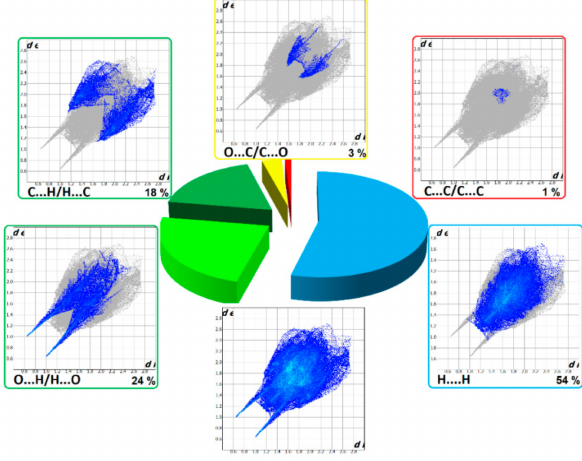
Figure 8. Full two-dimensional (2D) fingerprint plots of 1 , and those delineated into the major non-covalent interactions: H ... H, O ... H / H ... O, C ... H / H ... C and O ... C / C ... O. ... π They reciprocate π contacts, at the level ~ 1.5 %. and appear as adjacent blue / red triangles